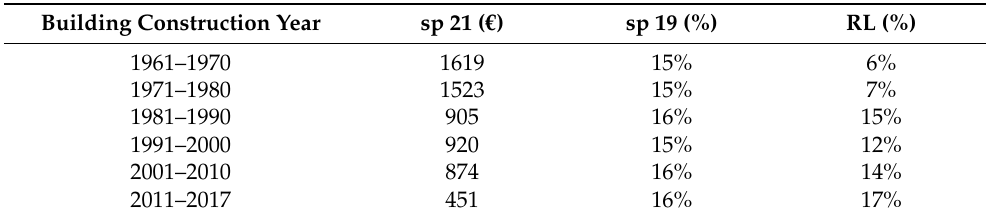
Table 5. Average annual cost ( € ) of space heating electricity with stable 21 ◦ C set point and savings (%) with different temperature setpoints.